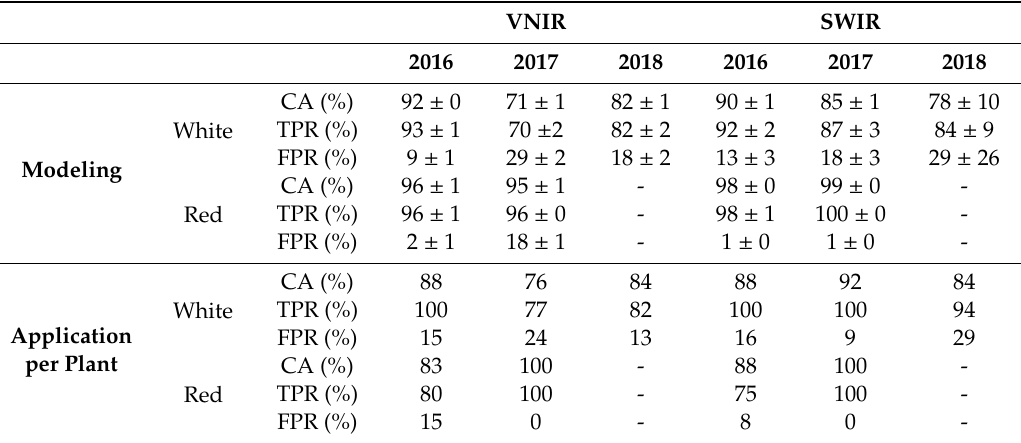
Table 12. Results for symptom-based (white and red) di ff erentiation of GLRaV-1 and GLRaV-3 infected field-grown grapevines. For modeling, all pixels were evaluated not considering spatial scales. Developed models were then applied per plant using all leaves for majority voting.